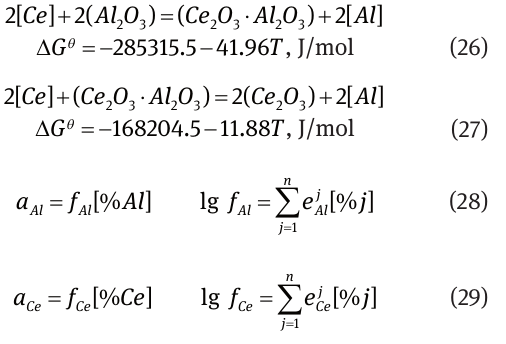
Fig. 7: Ce 2 O 3 , Ce 2 O 3 ⋅ Al 2 O 3 and Al 2 O 3 formation conditions of